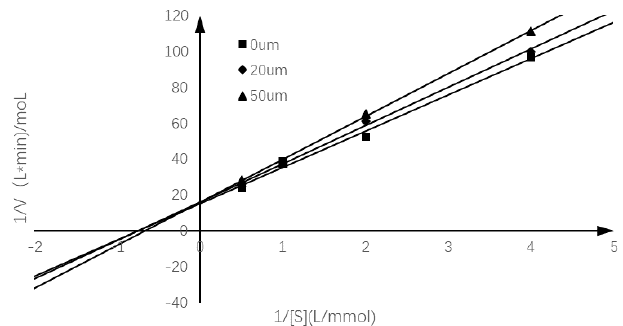
Figure 3. Lineweaver–Burk plot of chalcomoracin inhibition of α -glucosidase. Table 1. Enzymatic kinetic parameters of chalcomoracin on α -glucosidase. Chalcomoracin Concentration Lineweaver–Burk